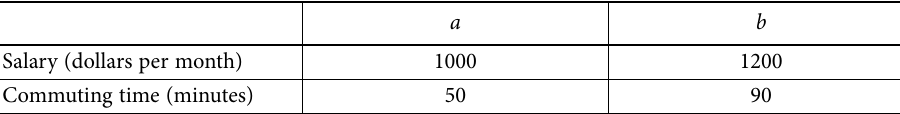
Table 1. Values of salary and commuting time of a and